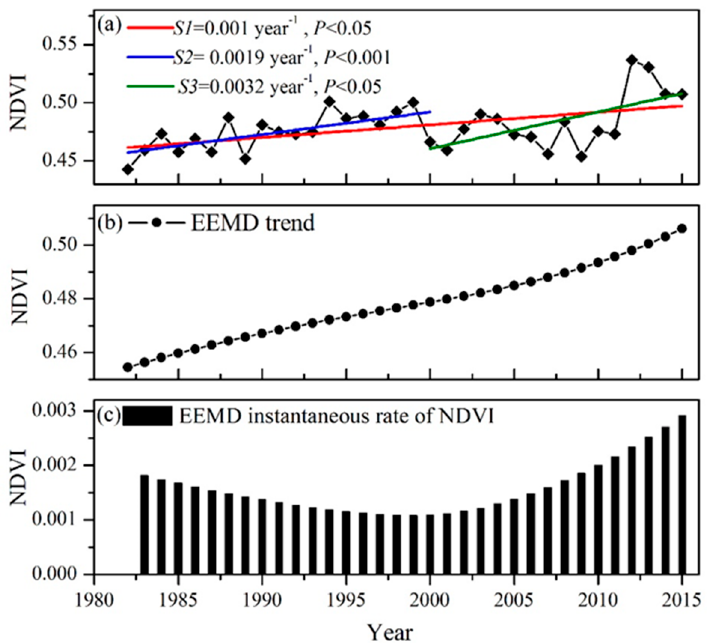
Figure 7. Annual NDVI trend during 1982–2015: ( a ) the S1 , S2 , and S3 mean linear trends of the